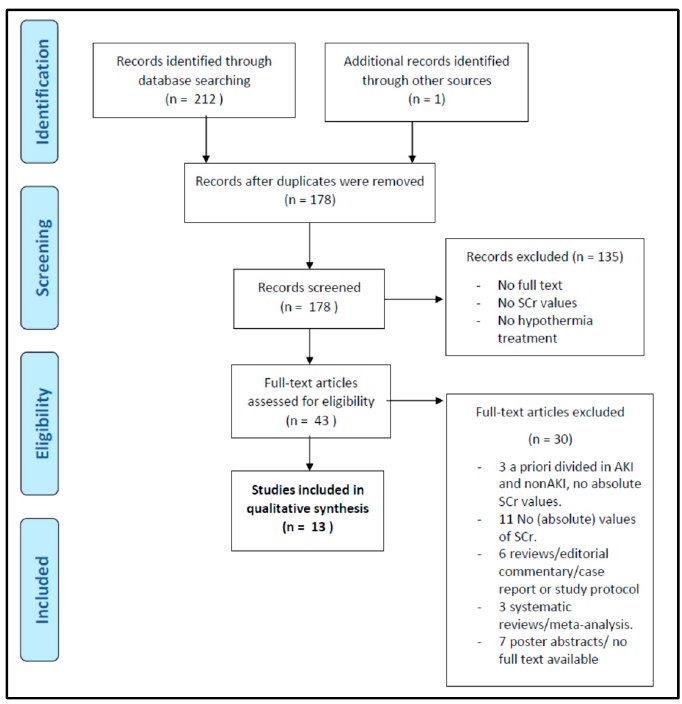
Figure 2. PRISMA flow diagram of the systematic search strategy.